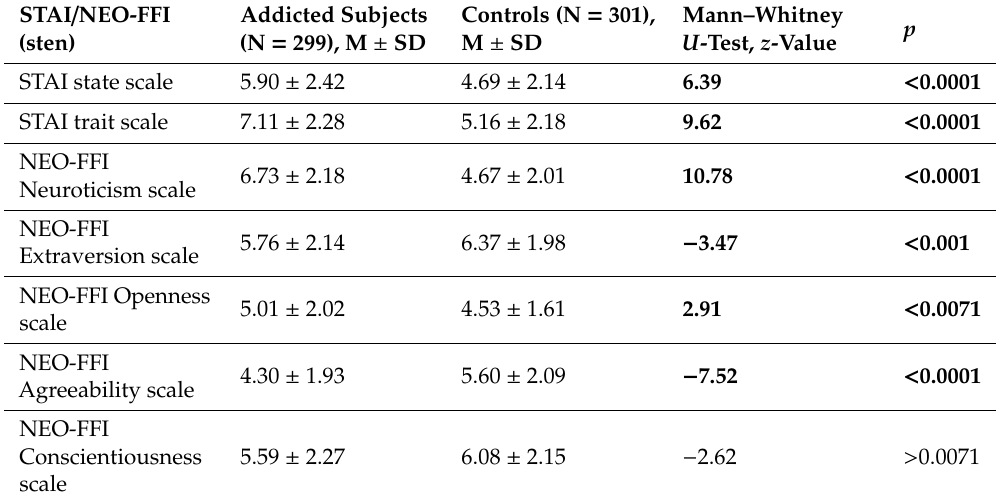
Table 3. Analysis of the State–Trait Anxiety Inventory, NEO Five-Factor Inventory results in the addicted subjects and in the